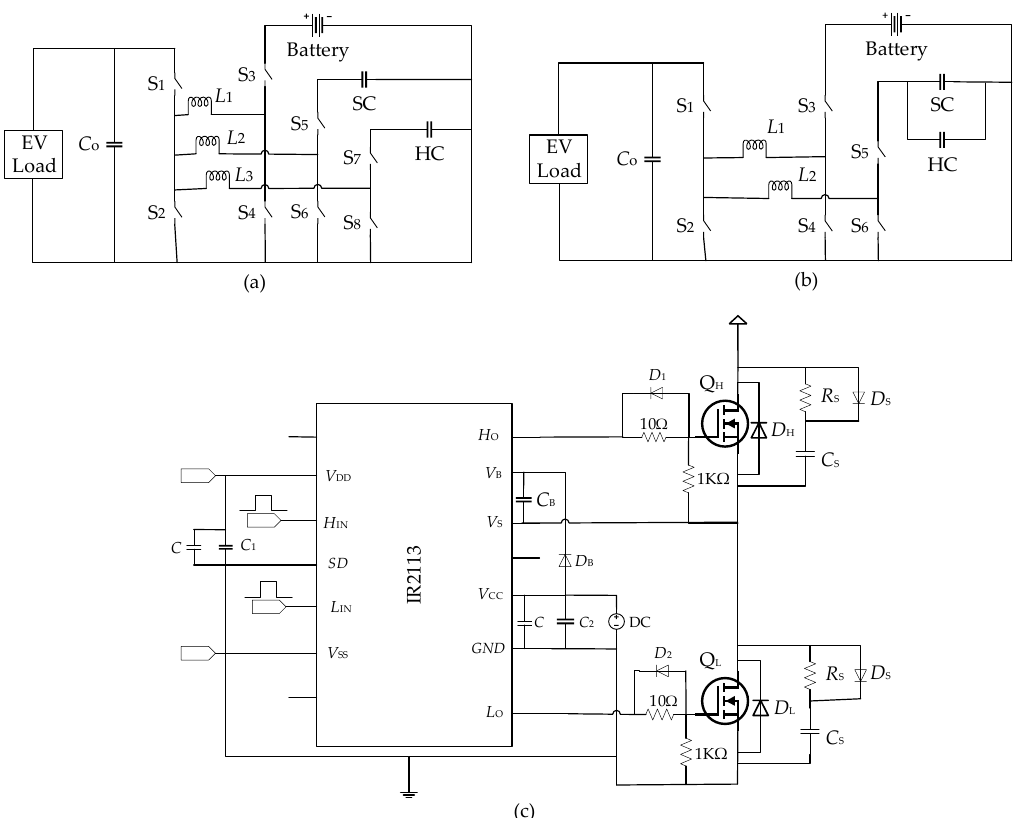
Figure 4. The implementation circuit of ( a ) the conventional hybridisation topology using a three-input converter; ( b ) the proposed hybridisation topology having SC and HC directly connected in parallel; and ( c ) the experimental implementation of the converter high side and low side switches with the MOSFET driver.